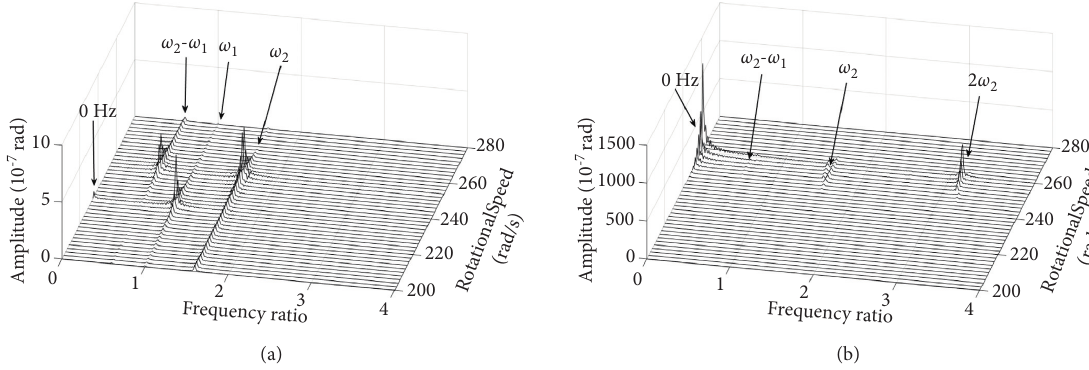
Figure 15: Waterfall spectrum plots for the torsional vibration of disk 4 during hovering flight. (a) Without rub-impact. (b)